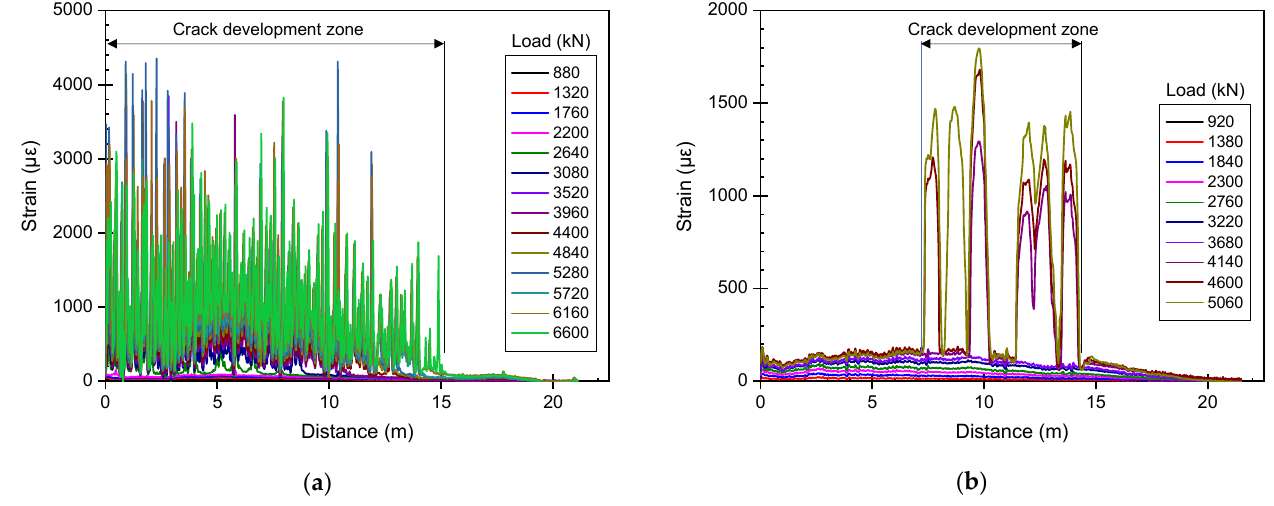
Figure 7. Strain distribution of the piles under different loads: ( a ) KB1; ( b ) KB2.